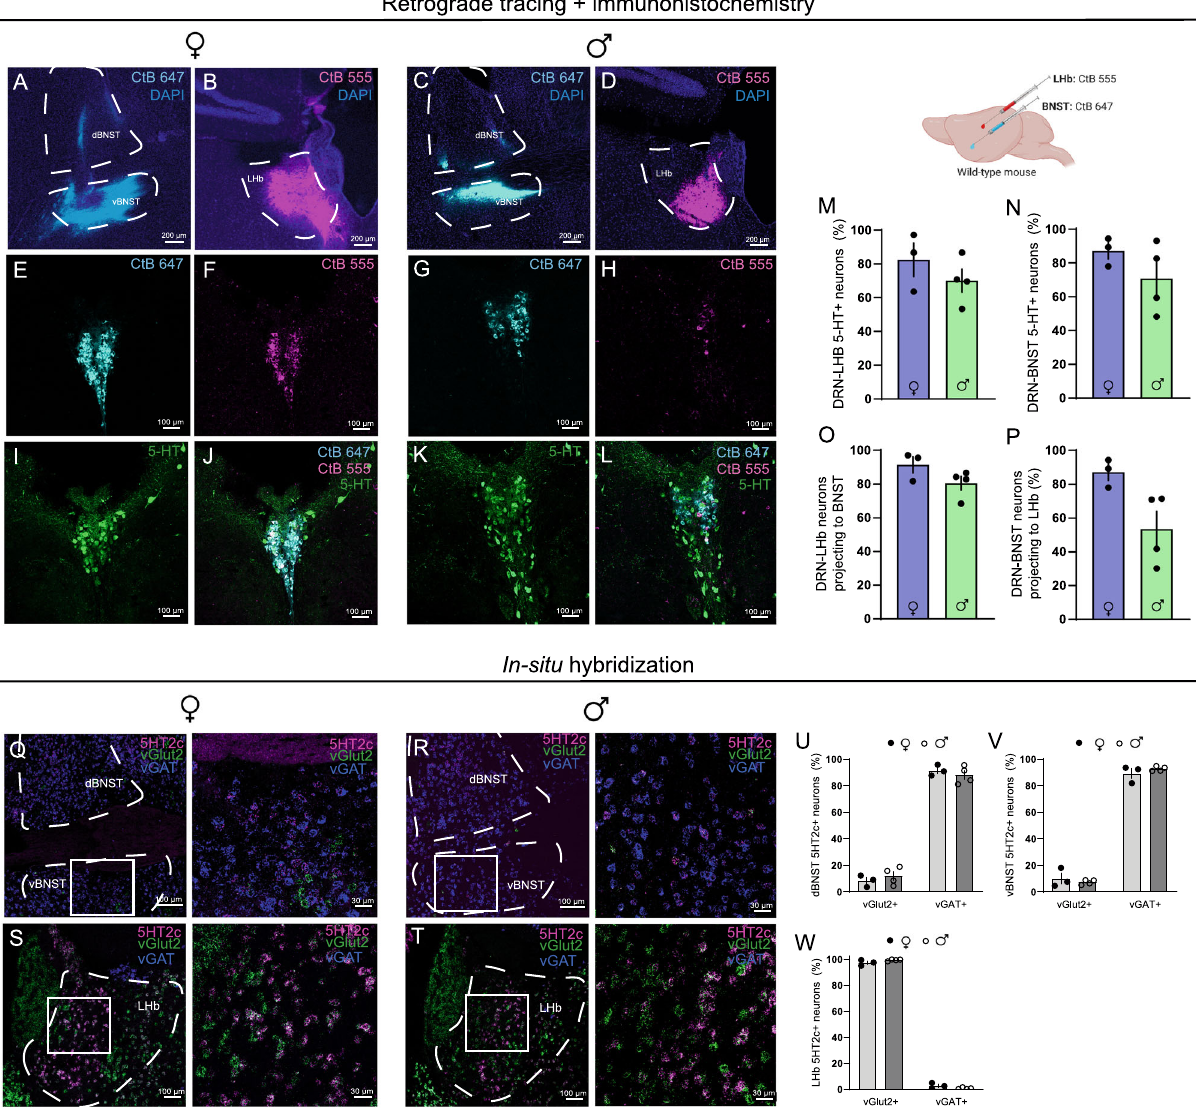
Fig. 3 | Anatomical and neurochemical characterization of DRN-LHb and DRN- BNSTcircuits.A RepresentativeCtB647infectioninBNST,females.Similarimages were obtained in n =3 mice B Representative CtB 555 infection, females. Similar images were obtained in n =3 mice. C Representative CtB 647 infection in BNST, males. Similar images were obtained in n =4 mice. D Representative CtB 555 infection in LHb, males. Similar images were obtained in n =4 mice. E RepresentativeCtB647labelinginDRN,females.Similarimageswereobtainedin n =3 mice. F Representative CtB 555 labeling in DRN, females. Similar images were obtained in n =3 mice. G Representative CtB 647 infection in BNST, males. Similar images were obtained in n =4 mice. H Representative CtB 555 infection, males. Similar images were obtained in n =4 mice. I Representative 5HT labeling in DRN, females. Similar images were obtained in n =3 mice. J Representative labeling in DRN for CtB 647, CtB 555, and 5HT, females. Similar images were obtained in n =3 mice. K Representative5HTlabelinginDRN,males.Similarimageswereobtainedin n =4 mice. L Representative labeling in DRN for CtB 647, CtB 555, and 5HT, males.